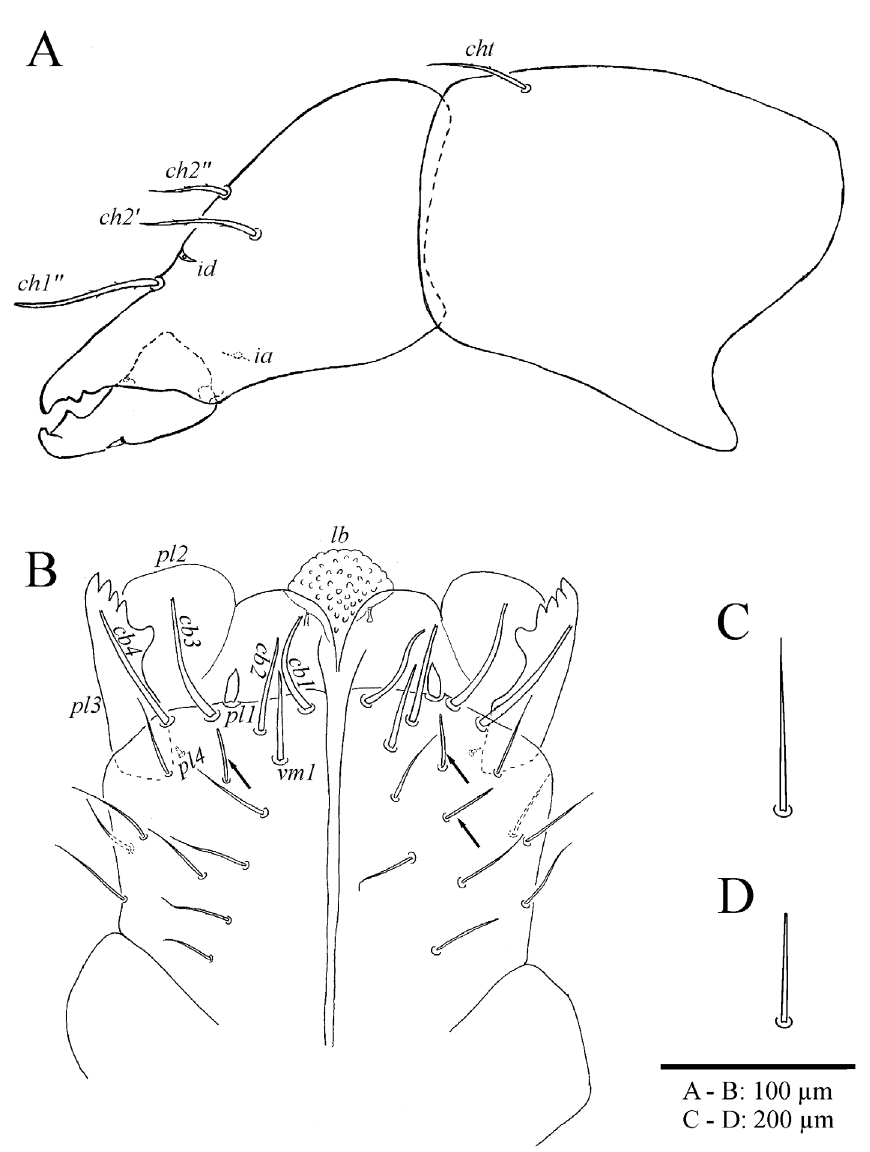
Figure 2. Neocarus spelaion sp. n. (Female): A Lateral view of chelicerae B Ventral view of subcapitulum C Detail of a seta with a fine tip D Detail of a seta with a rounded tip, found only in females (arrows in Fig. B). Abbreviations; cb1 – 4 = circumbuccal setae, pl1–4 = paralabial setae, ch = cheliceral setae, cht = basal segment seta, lb = labrum, id = dorsal lyrifissure, i α = antiaxial lyrifissure. lho et al., setember.2016, manual collection. Paratype 1 male specimen deposited at MZLQ, same data as holotype; paratype 1 male specimen deposited at ISLA, same data as holotype; 1 female specimen deposited at ISLA, same data as holotype;